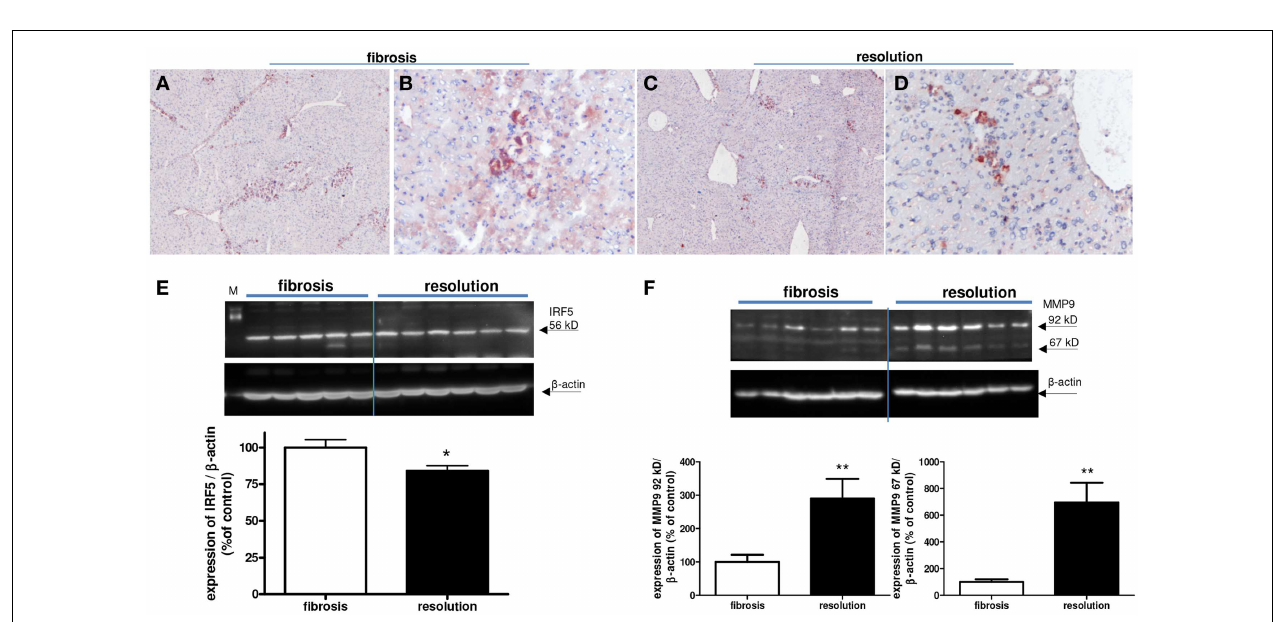
expression in fibrosis versus resolution group, and (F) western blot quantification of MMP9 expression in fibrosis versus resolution group. A 92kDa pro-form and a 67kDa processed form of MMP9 is significantly increasingly expressed in livers undergoing resolution. * p < 0.05, ** p < 0.01. N =